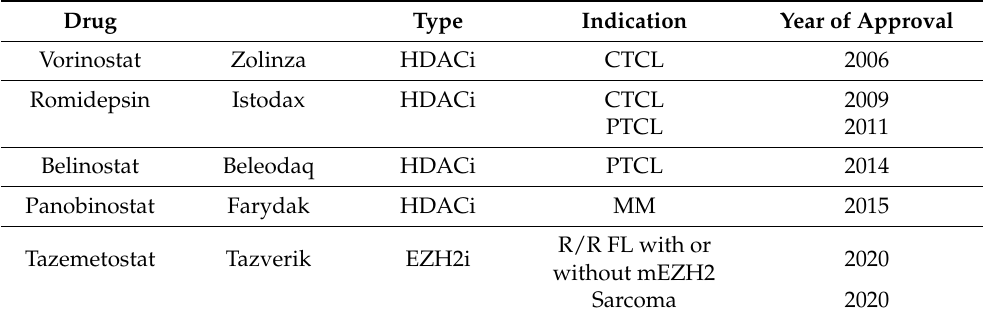
Table 1. Drugs approved as second-line therapy for relapsed/refractory B-NHL and other